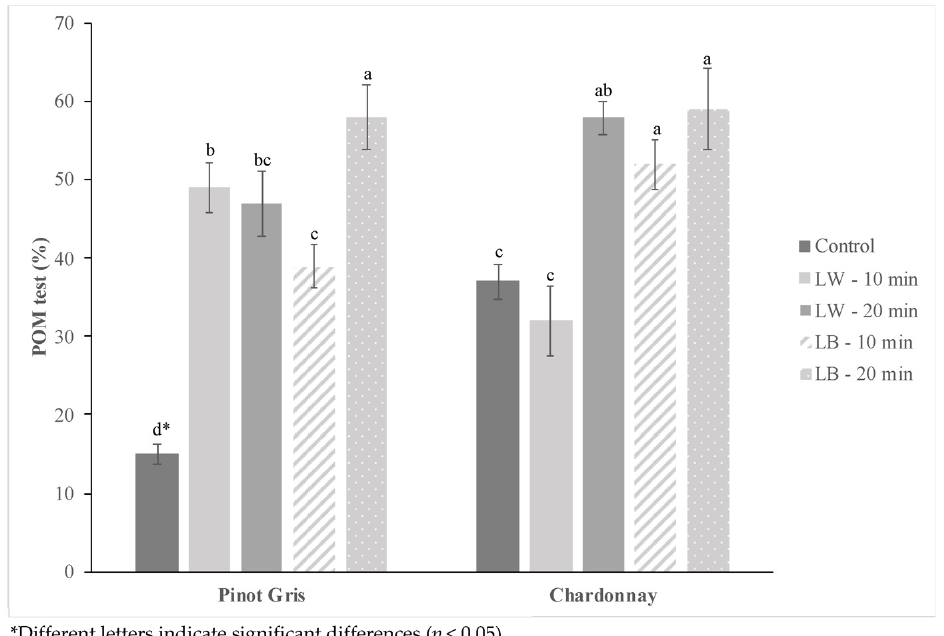
Figure 3. POM test value of Pinot Gris and Chardonnay wine before (Control) and after different light color (white and light blue) exposures at 10 and 20 min.